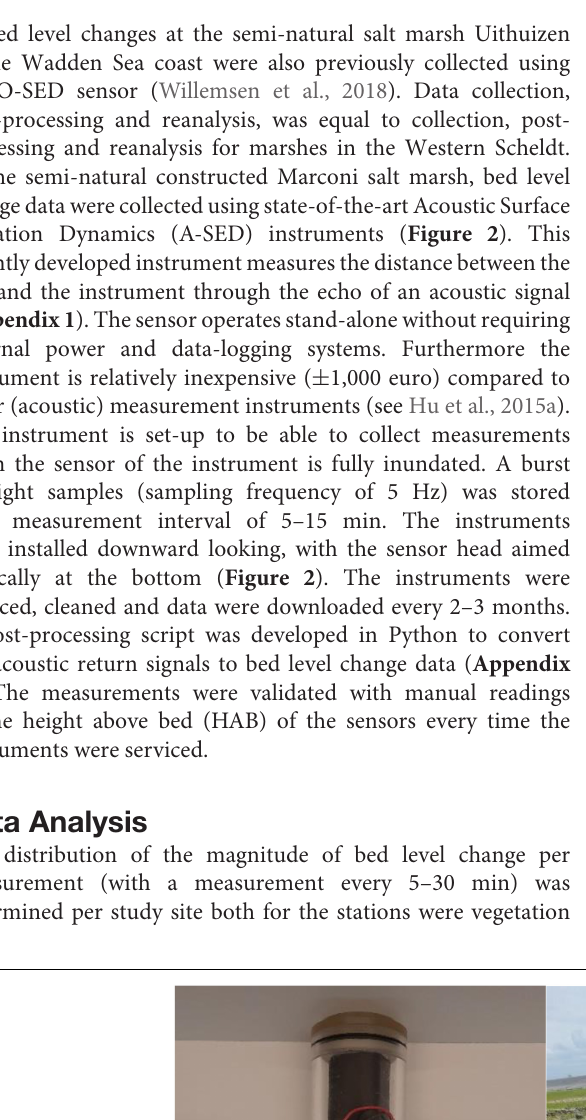
Frontiers in Marine Science |